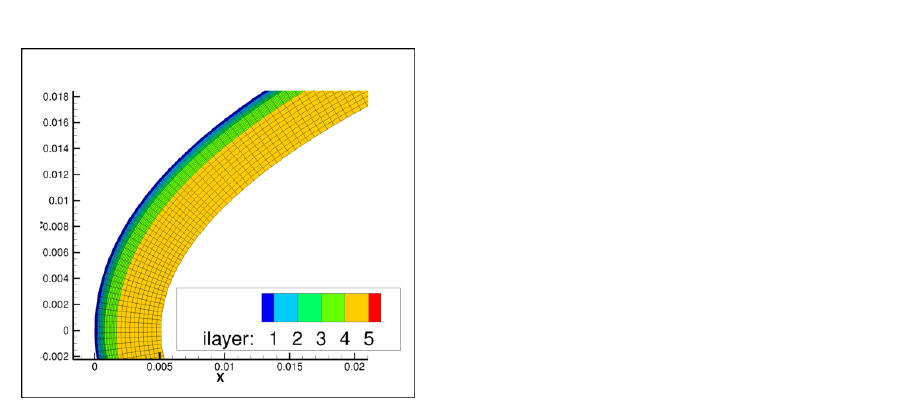
Figure A9. Mesh of the electrothermal system in the upper part of the leading edge.